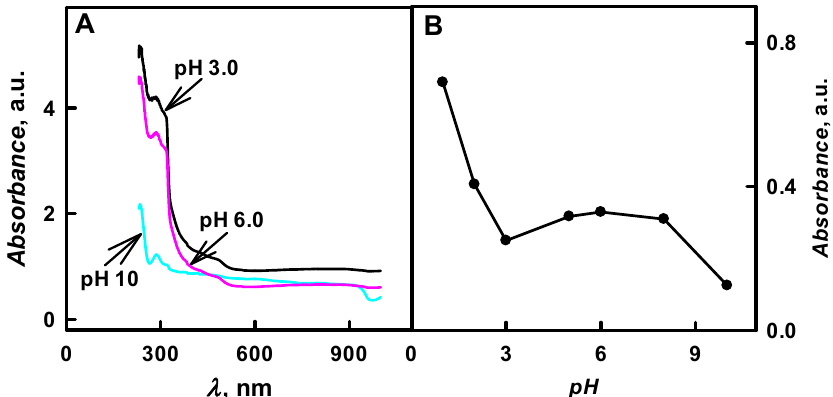
Figure 2. ( A ) Spectra of colloidal solutions of PANI/GOx composite nanoparticles synthesized at various solution pH values and ( B ) the influence of polymerization bulk solution pH on the absorbance at λ max = 440 nm. (The composition of polymerization solution: 0.05 mol L − 1 of glucose, 0.50 mol L − 1 of aniline and 0.75 mg mL − 1 of glucose oxidase at pH 1.0–10; 48 h lasting polymerization was performed. Optical absorbance was registered in 0.05 mol L − 1 SA buffer, pH 6.0).